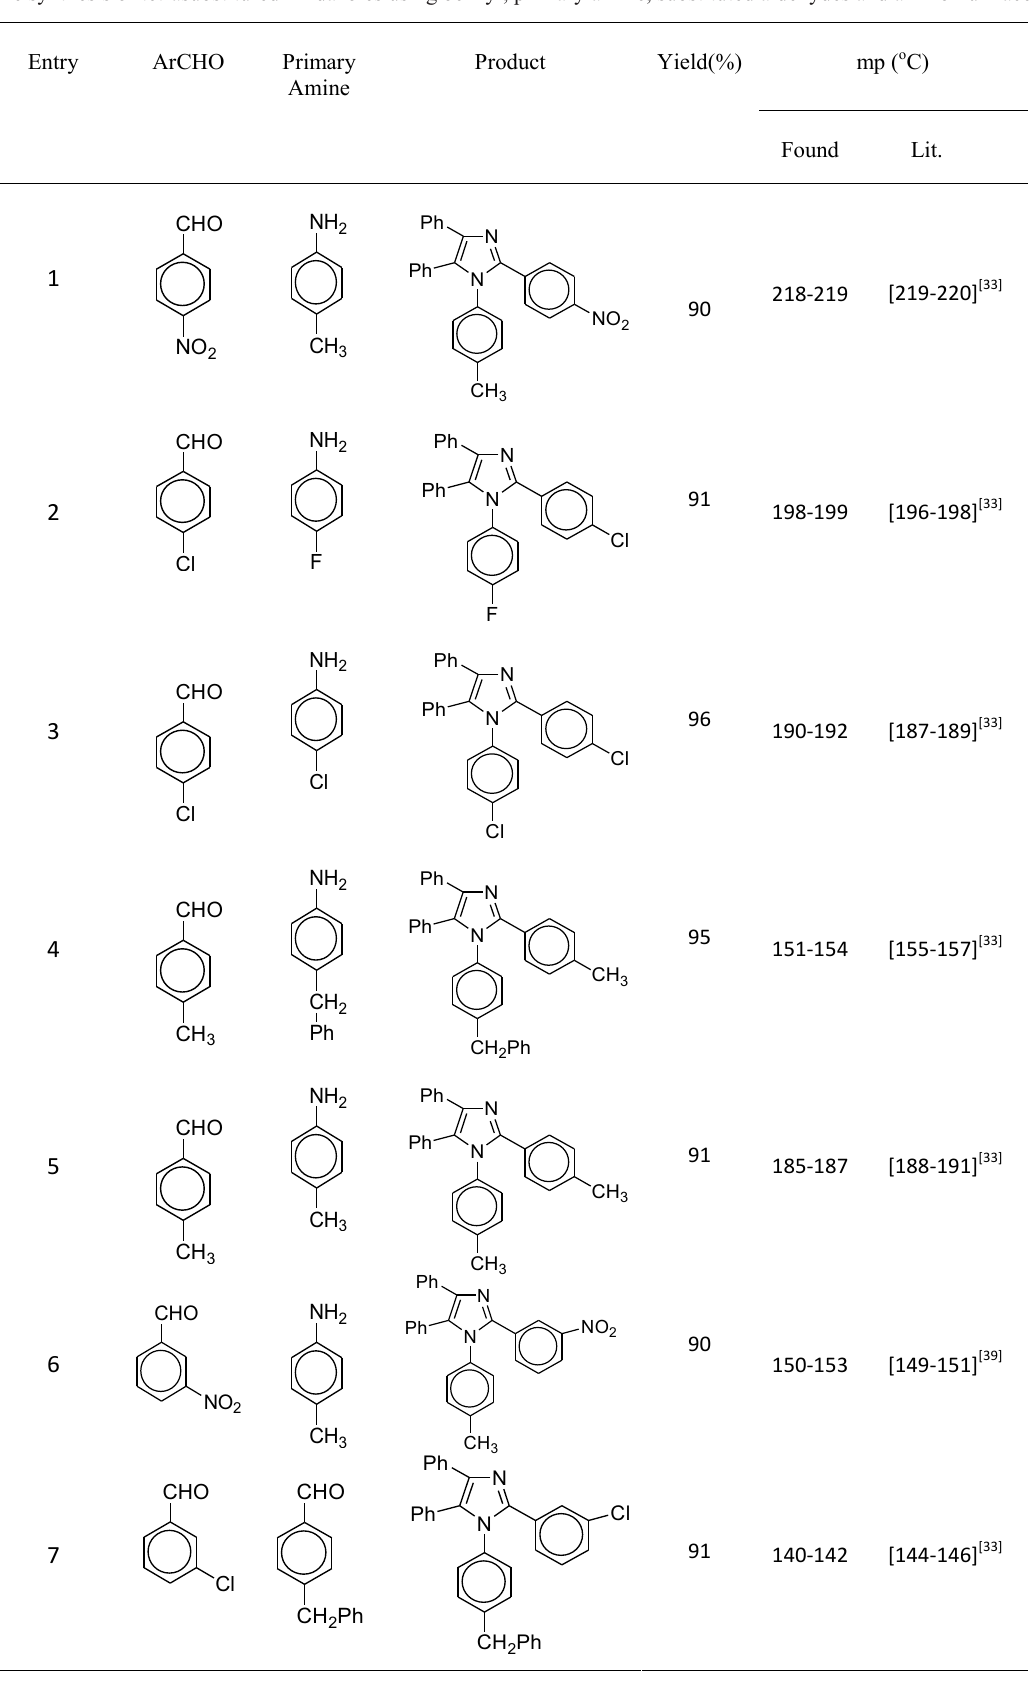
Table 4. The synthesis of tetrasubstitured imidazoles using benzyl, primary amine, substituted aldehydes and ammonium